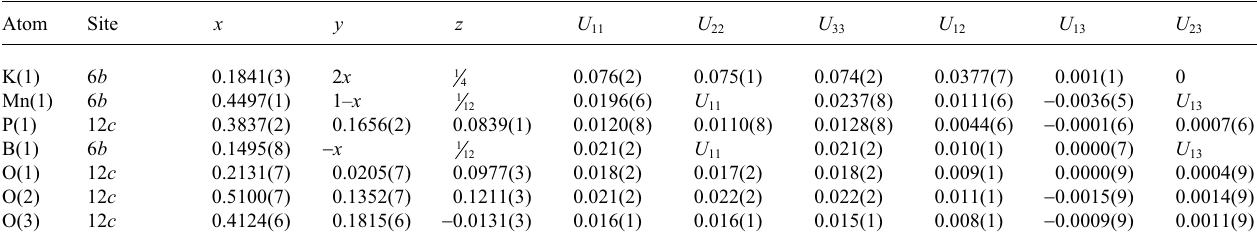
Table 3. Atomic coordinates and displacement parameters (in Å 2 ).